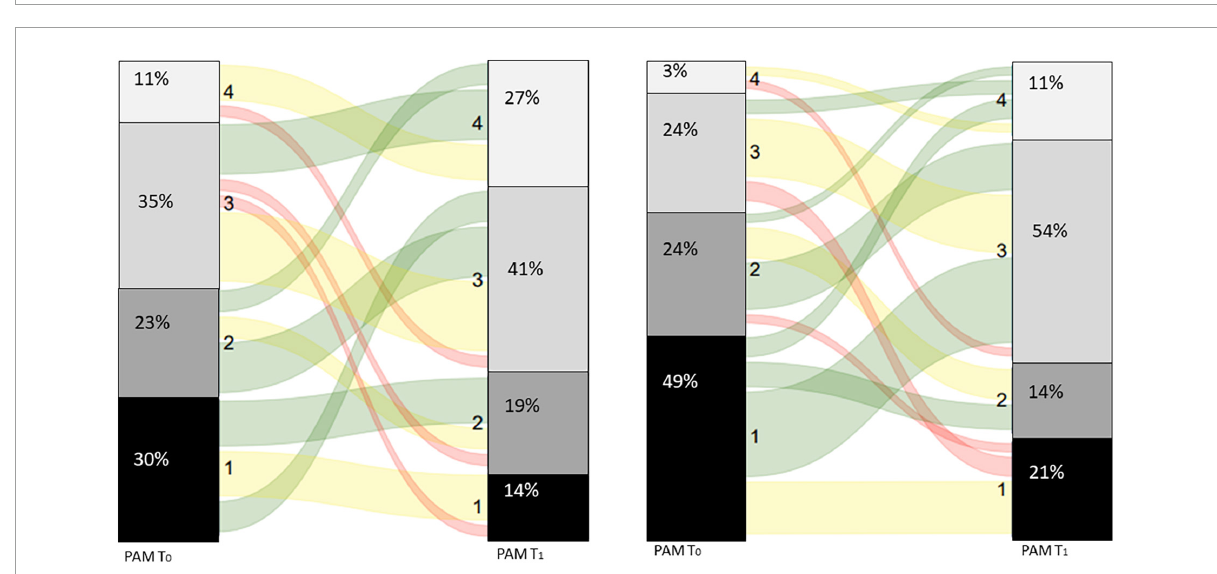
FIGURE3 Sankey diagram for patients with asthma (left panel) and patients with COPD (right panel)